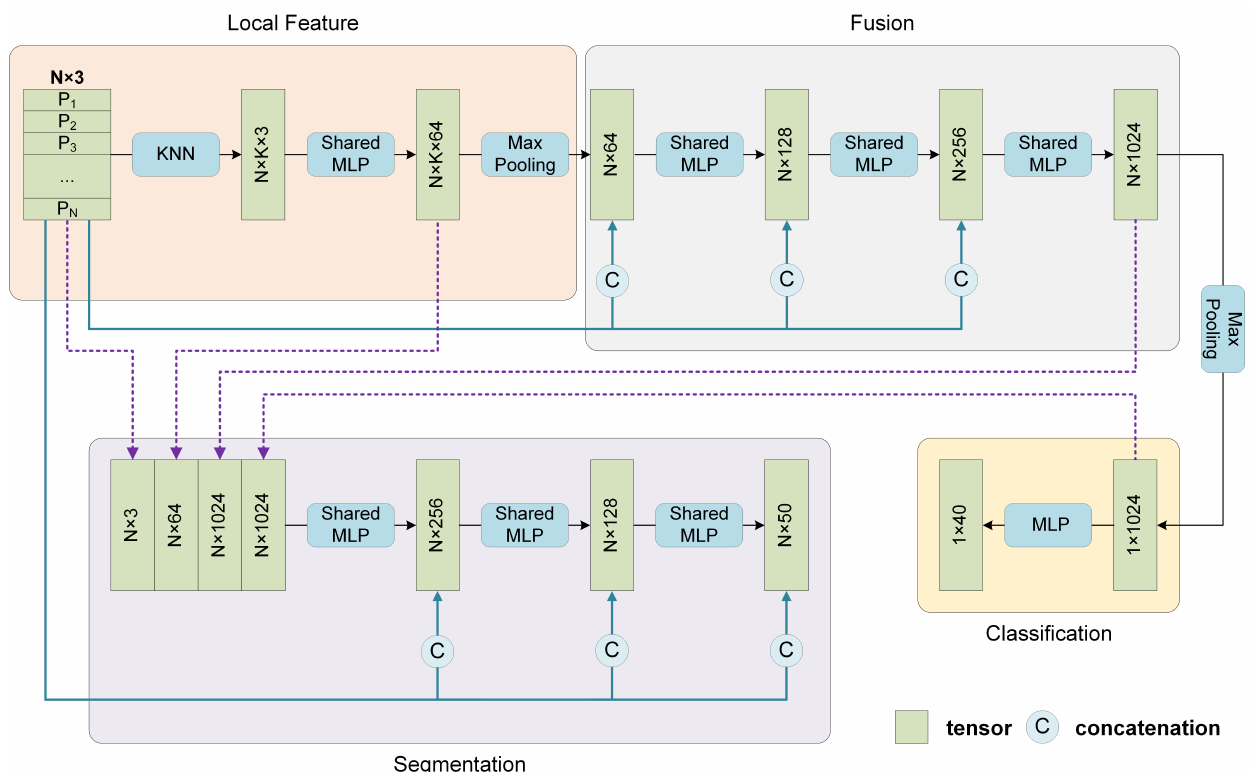
Figure 6. Network architecture for classification and part segmentation tasks. Some network layers are omitted for clarity.